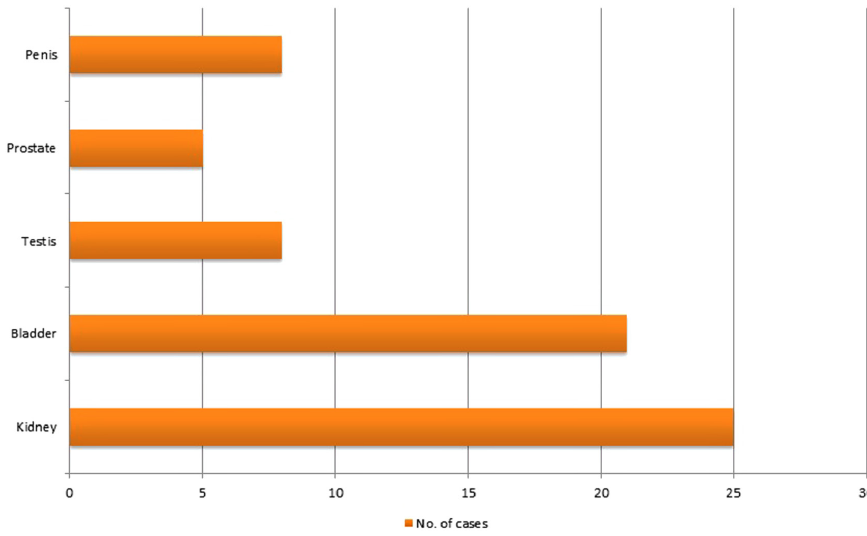
Figure 1. Frequency of cases of Urological malignancies, with hypercalcemia, reported in the literature, to